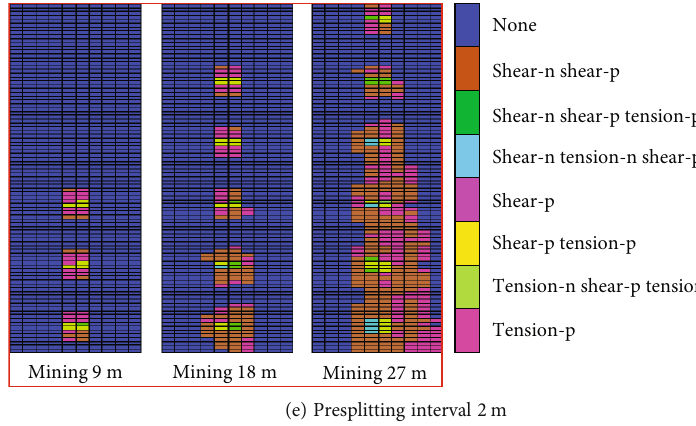
Figure 6: Plastic damage evolution process of rock mass in the presplitting